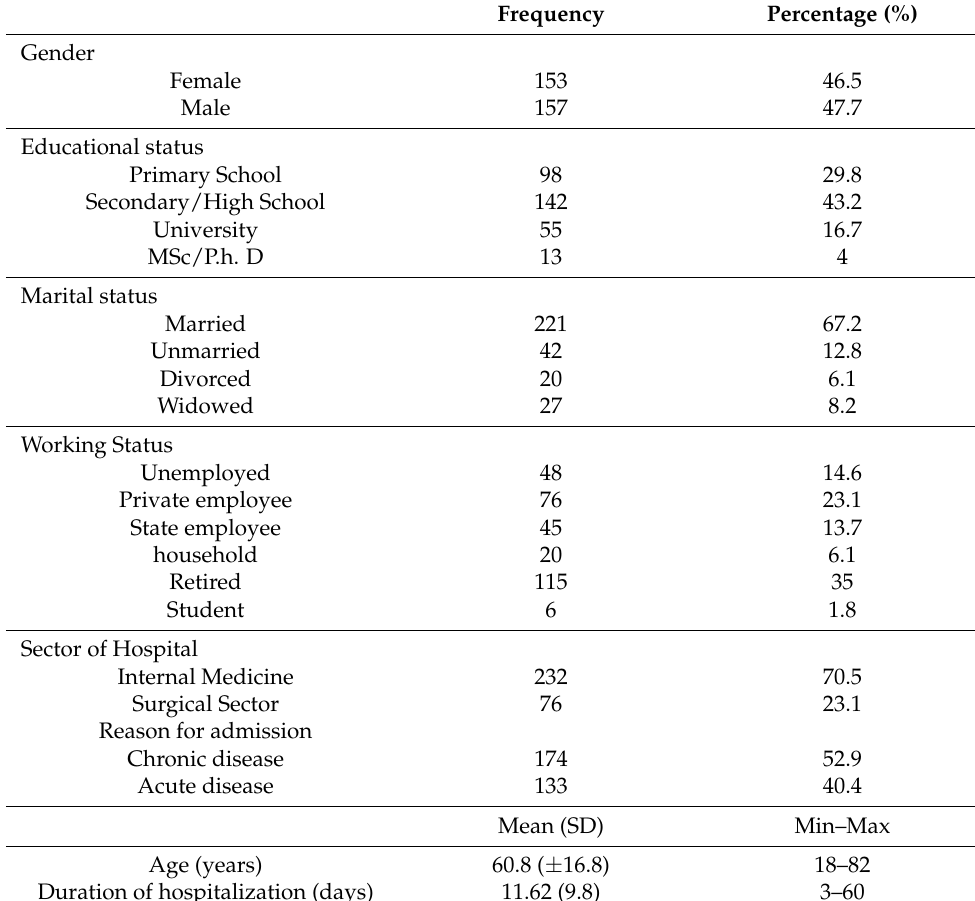
Table 1. Patients’ demographic and clinical characteristics (N =